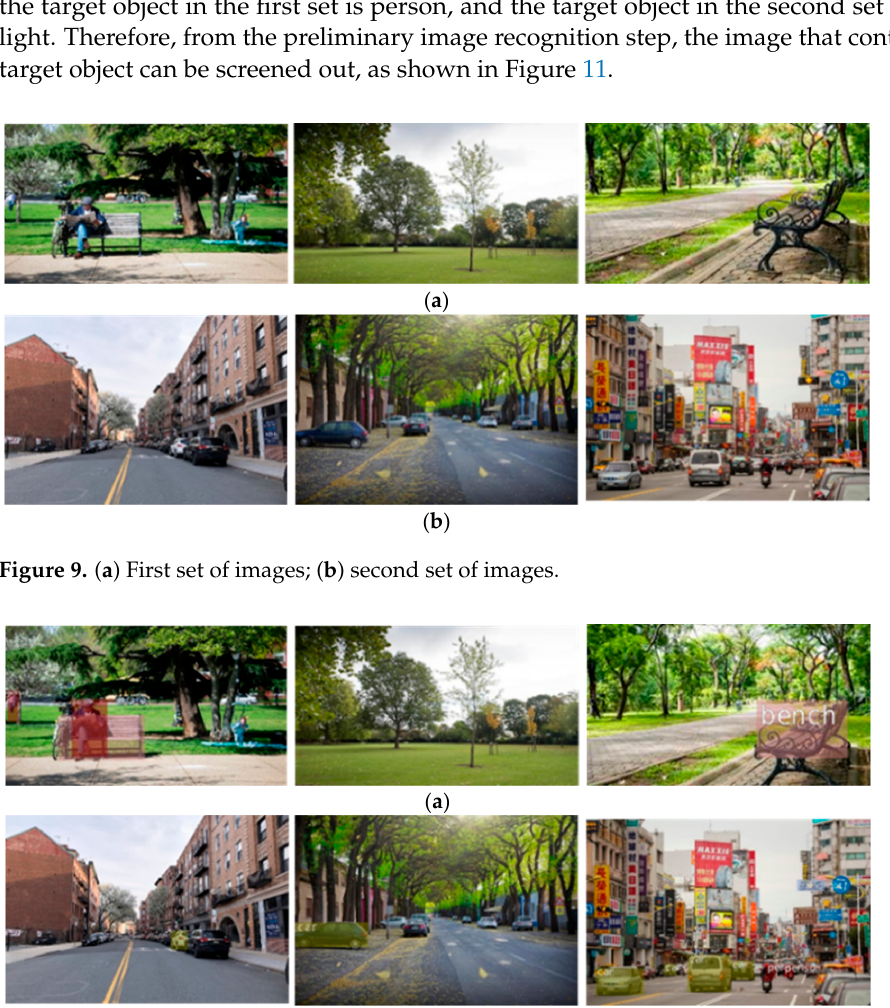
( b ) Figure 11. Results of preliminary identification: ( a ) first set; ( b ) second set. Figure 12. Overview of the image captioning process. In object recognition, the processing algorithm is subdivided into the steps of object segmentation and color analysis. When an image is given as an input to the object recog- nition algorithm, the algorithm will first recognize the object, including its range and po- sition. Then, the algorithm extracts the color of each pixel from the segmented image and converts it into HSV values. After analyzing the color composition of objects, the main